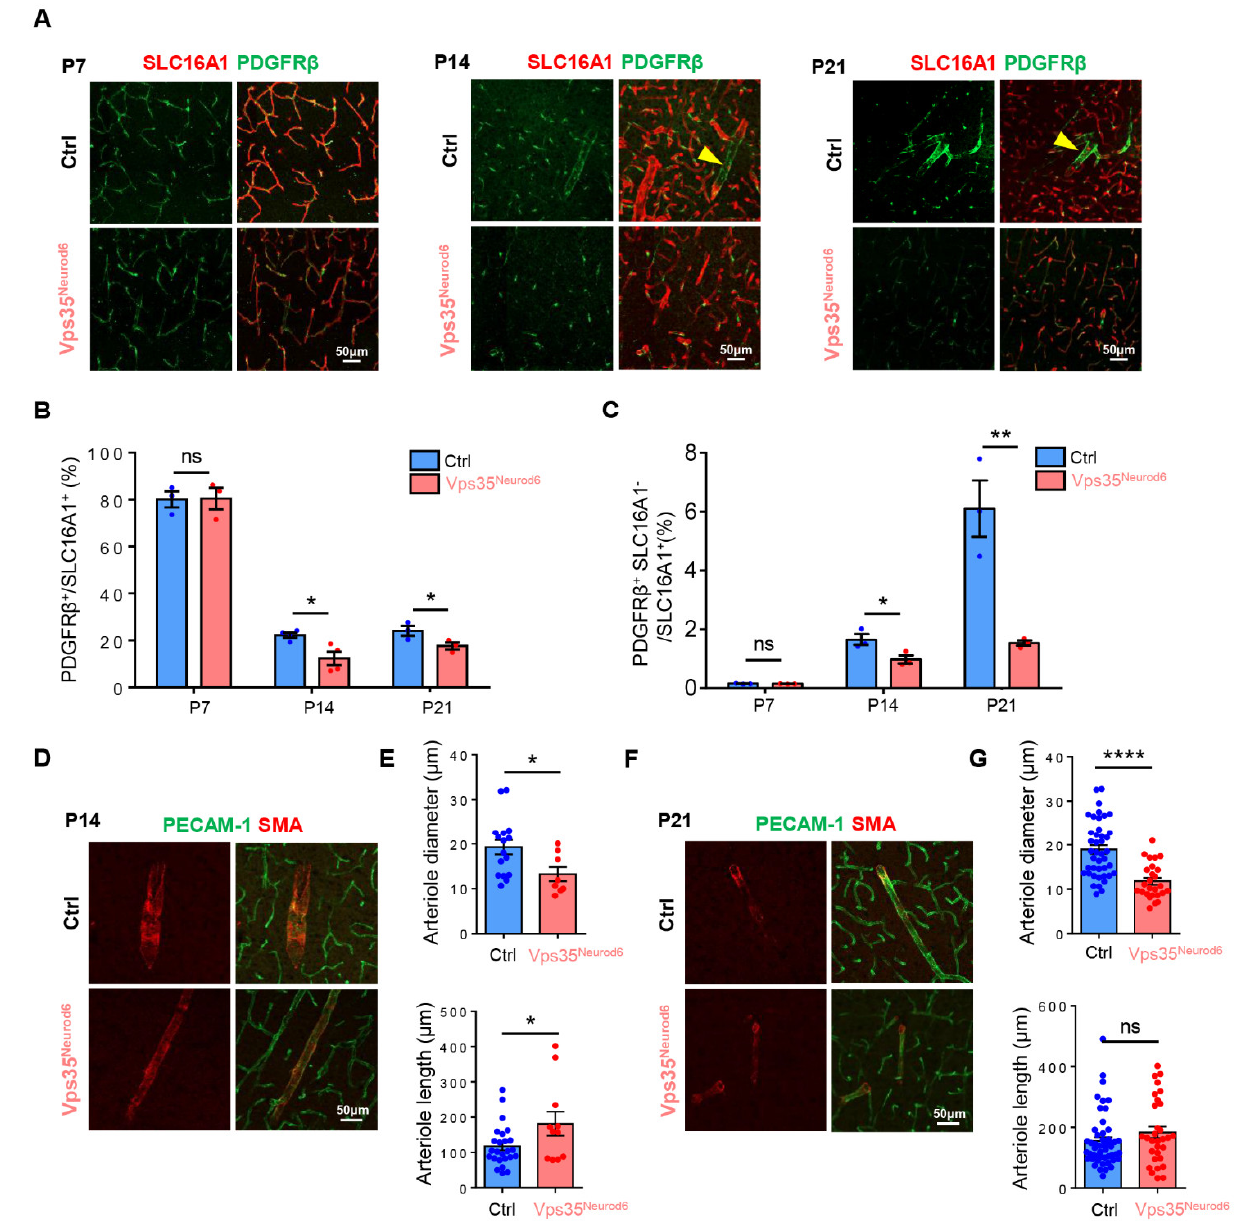
Figure 4. Reduced pericytes and thinner arterioles in Vps35 Neurod6 cortex at P14 and P21. ( A ) Repre- sentative images of cortical brain sections coimmunostained with PDGFR β (green) and SLC16A1 (red) at indicated age. ( B ) Quantification analysis of PDGFR β in control and Vps35 Neurod6 mice revealed an age-dependent decrease (n = 3~4 mice per group; two-tailed unpaired t test). ( C ) Quantification analysis of PDGFR β + SLC16A1 - cells in control and Vps35 Neurod6 mice revealed an age-de- pendent decrease (n = 3~4 mice per group; two-tailed unpaired t test). ( D ) Representative images of cortical brain sections coimmunostained with PECAM-1 (green) and SMA (marker of arterioles) (red) at P14. ( E ) Quantification of diameter and length of arterioles of control and Vps35 Neurod6 mice (n = 3~4 mice per group; two-tailed unpaired t test). ( F ) Representative images of cortical brain sec- tions coimmunostained with PECAM-1 (green) and SMA (red) at P21. ( G ) Quantification of diame- ter and length of arterioles of control and Vps35 Neurod6 mice (n = 3~4 mice per group; two-tailed un- paired t test). Scale bars as indicated in each panel. Individual data points are shown as dots with group mean ± SEM; * p < 0.05; ** p < 0.01; **** p < 0.0001; ns., not significant.